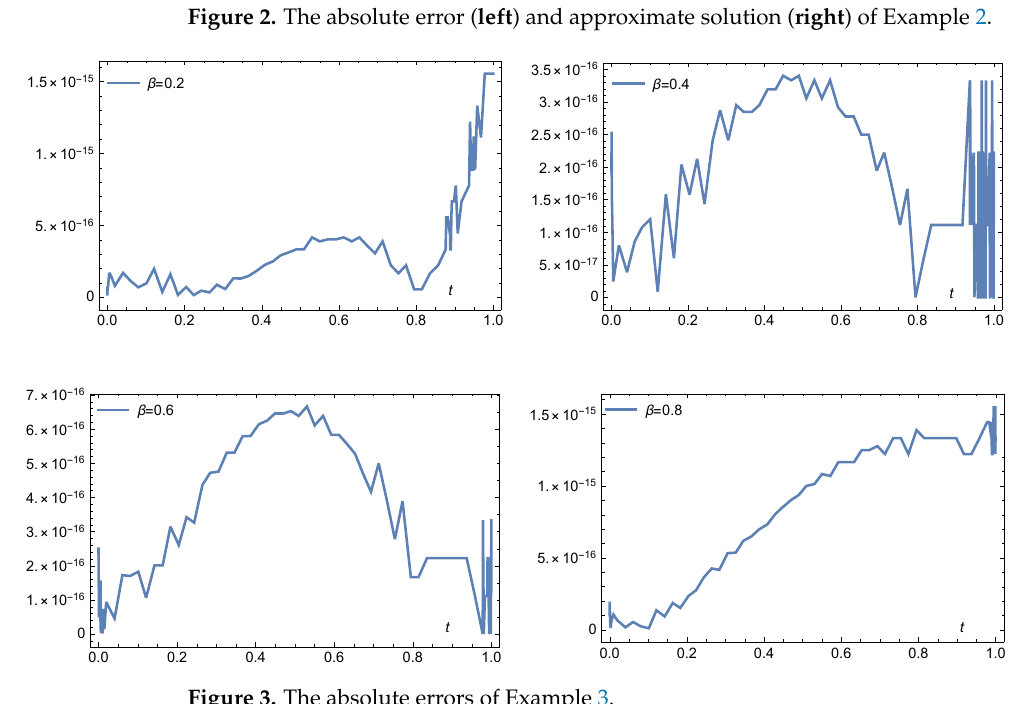
Figure 3. The absolute errors of Example 3. Table 3. L 2 and L ∞ errors of Example